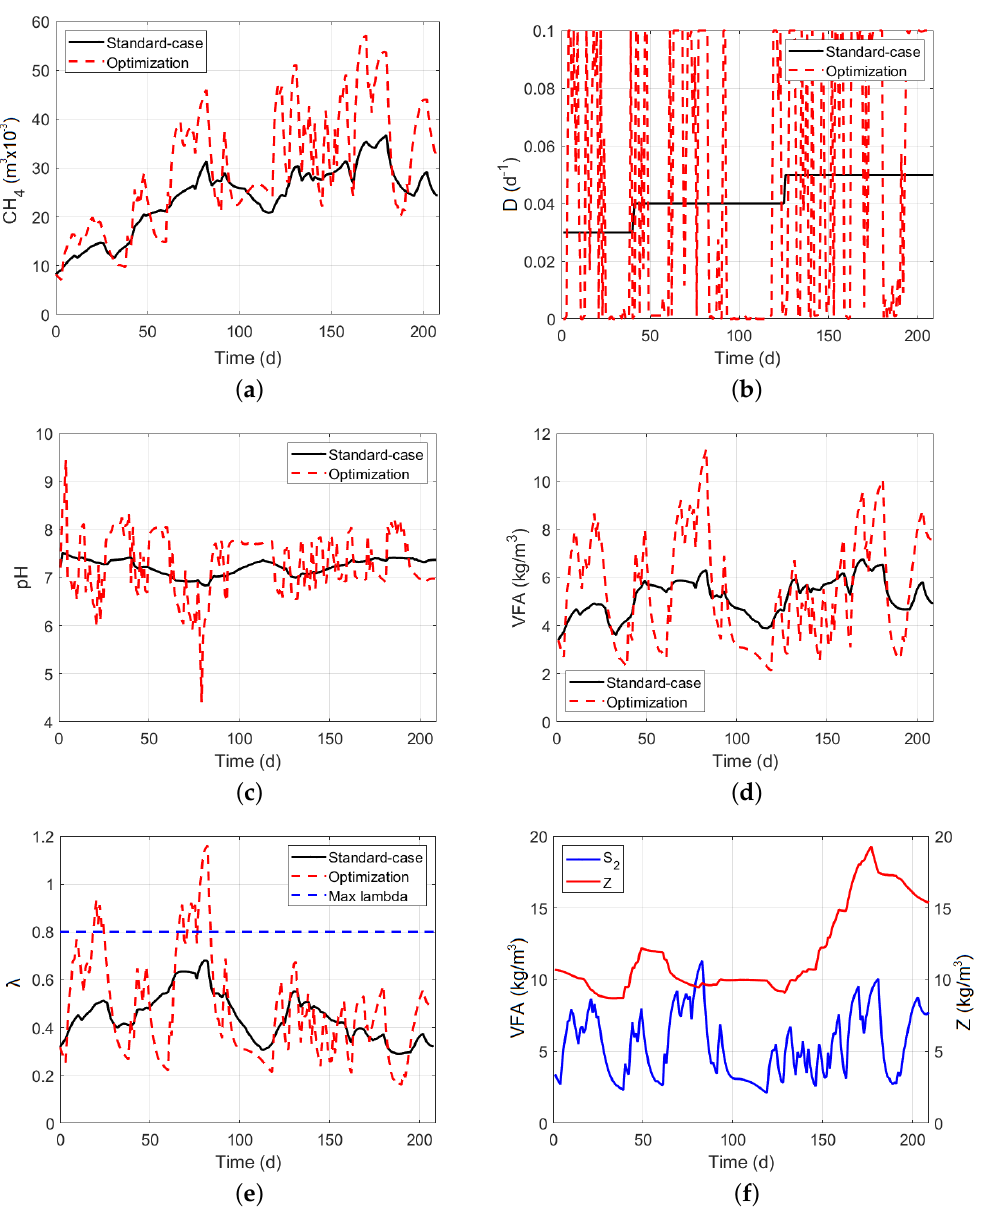
Figure 7. MPC controller without restrictions, maximizing the volume of CH 4 . Time course of ( a ) vol- ume of CH 4 ; ( b ) dilution rate D; ( c ) value of pH; ( d ) dynamic of VFA; ( e ) values of λ ; ( f ) dynamics of S 2 and